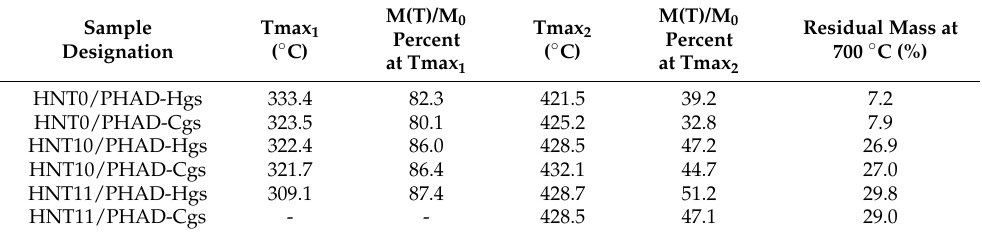
Table 2. Data presenting M(T)/M 0 percent and the maximum temperatures of rate decomposition (Tmax) of HNT-free hydrogel and cryogel (HNT0/PHAD-Hgs and -Cgs) and ternary hybrid hydrogel and cryogel (HNT10/PHAD and HNT11/PHAD-Hgs and -Cgs) prepared at HNT content 2.80% and 3.20% ( w / v